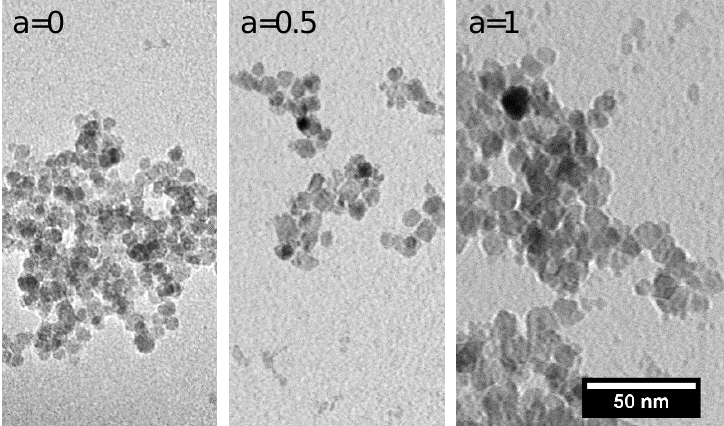
Figure 2. Typical TEM images of pure magnetite ( a = 0 ) and the particles with a Co content of 12.5% ( a = 0.5 ) as well as 25% ( a = 1 ) confirm a slight increase in the particle size for increasing the Co content of the particles. The aggregation of the particles occurs during the sample preparation (drying of the fluid) for the TEM imaging.